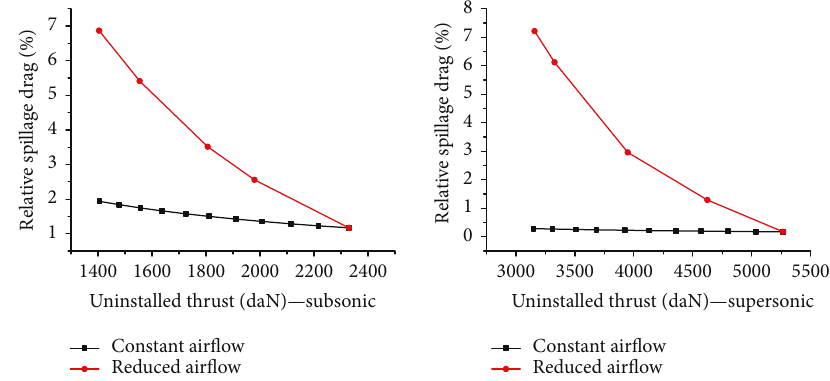
Figure 16: Variation of spillage drag during